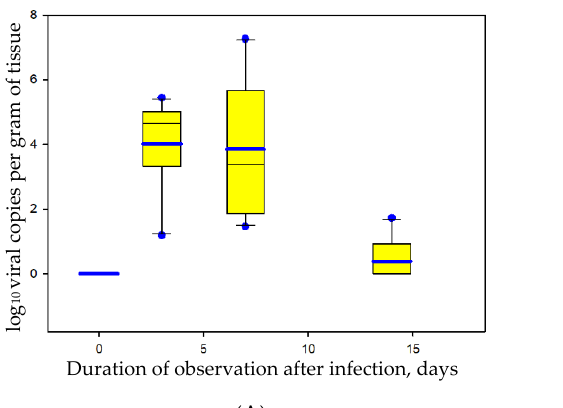
Table 1. Elimination rate and elimination half-life of virus from lung tissue in female Syrian ham- sters treated with Riamilovir (Triazavirin), 20 mg/kg, intraperitoneal, daily from 3 to 7 days after infection with SARS-CoV-2 (4.25 × 104 TCID50/mL) in dosage 26 µL/animal, intranasal. Adapted/Translated from Russian to English under the CC BY 3.0 license from Chepur, S.V., 2021 [76].